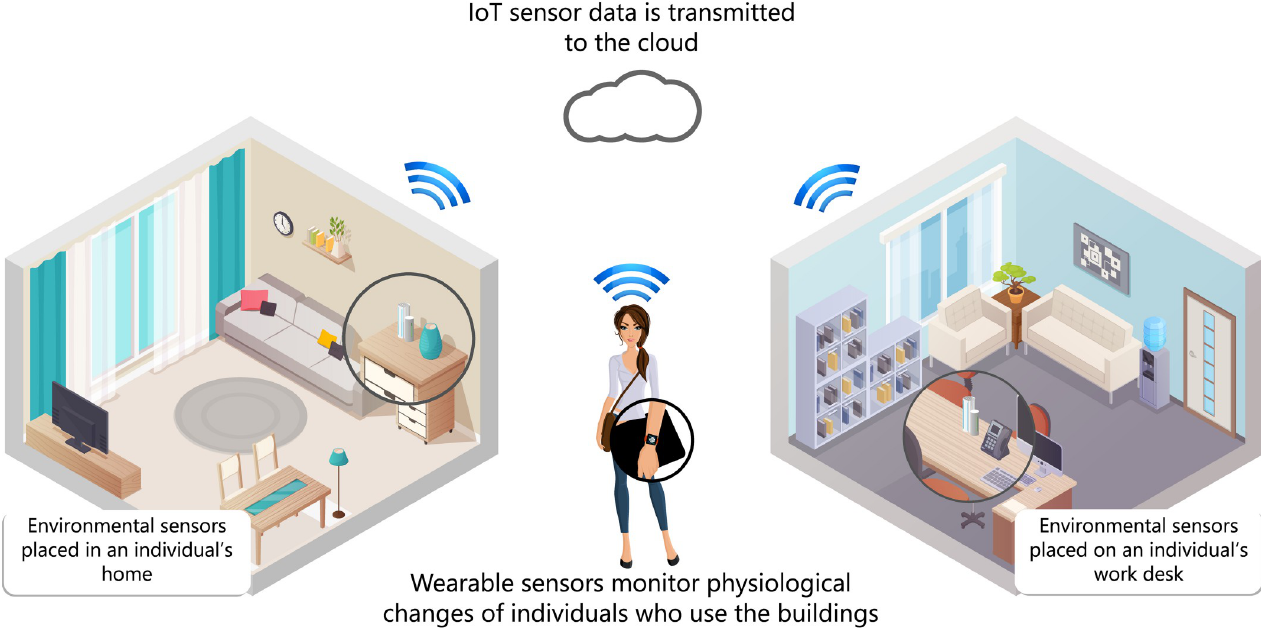
Fig 1. Diagram of the study setup and passive sensor